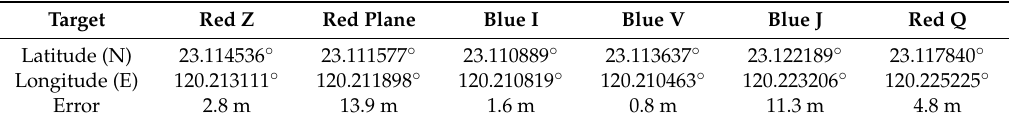
Table 3. Locating results of flight test